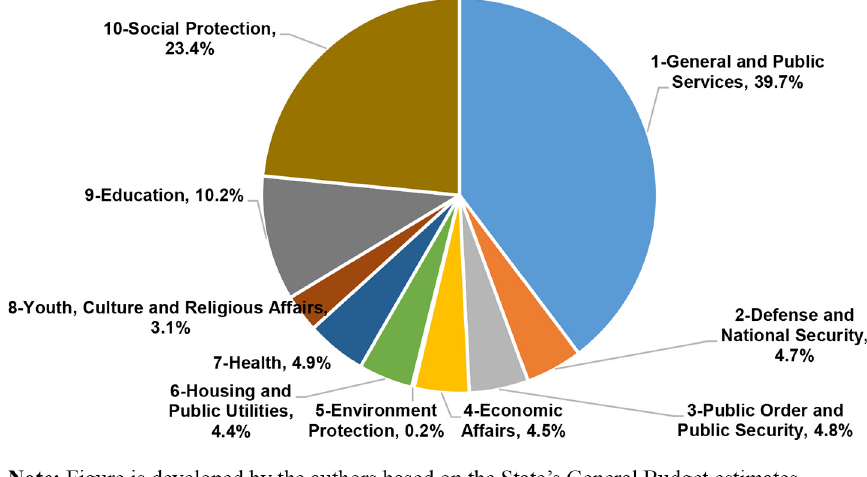
Figure 5. Egypt ’ s